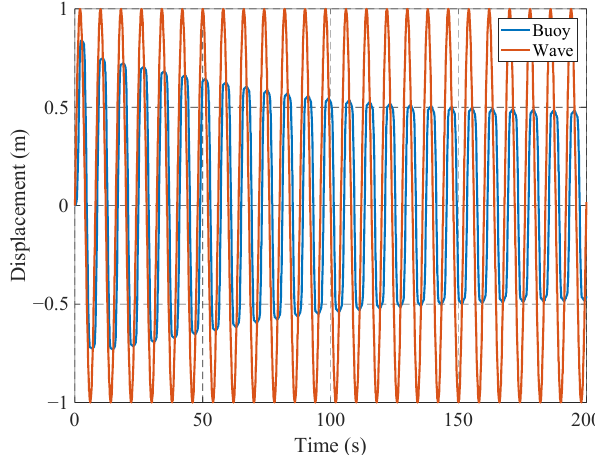
Figure 10. The displacement of the buoy and wave under the motor displacement is 150 cc/rev.